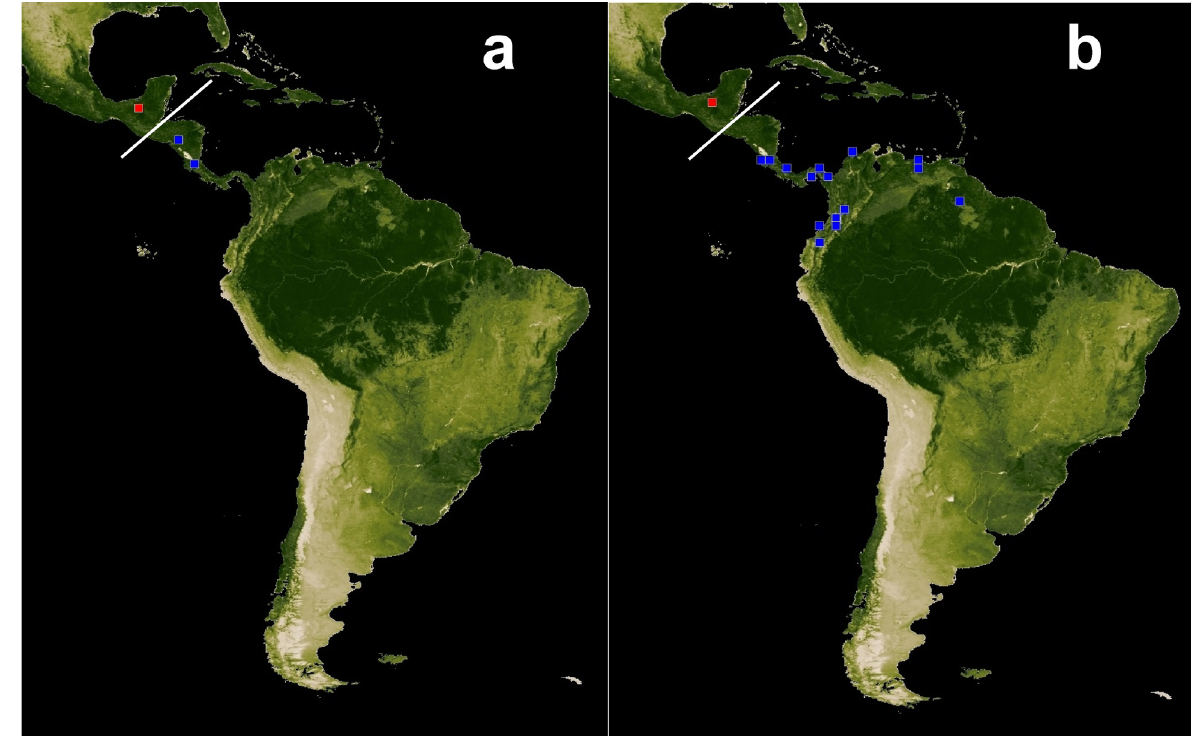
Figure 4 - SVe4 (Supported Vicariant event 4): (a) Farrodes tulija (red) and F. flavipennis (blue); (b) F. maya (red) and F. caribbianus (blue). White lines are for visual reference (they are located in the same place in all the